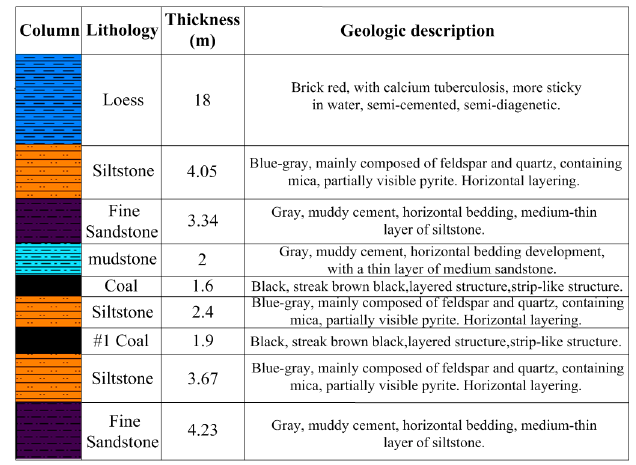
Figure 2. Stratum column and geological description of the mining panel.